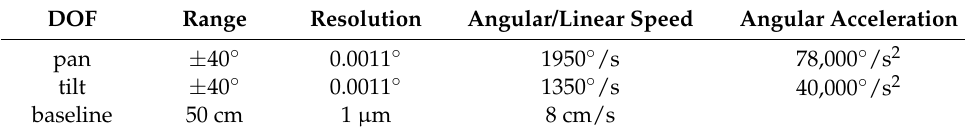
Table 2. Dynamic performance of the ASP.